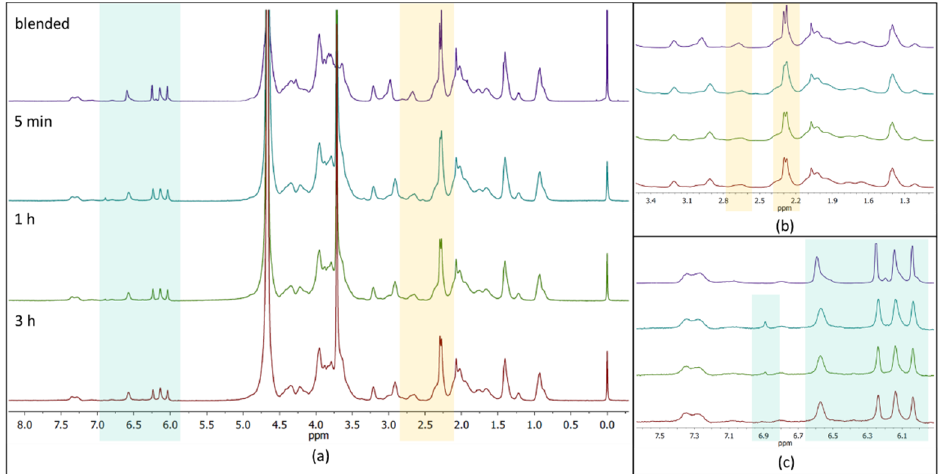
Figure 3. Comparison between 1 H NMR spectrum of blended polymers and real-time gel formation at 5 min, 1 h, and 3 h ( a ) with a focus on the area between 1–3.5 ( b ) and 6–7.5 ppm ( c ).